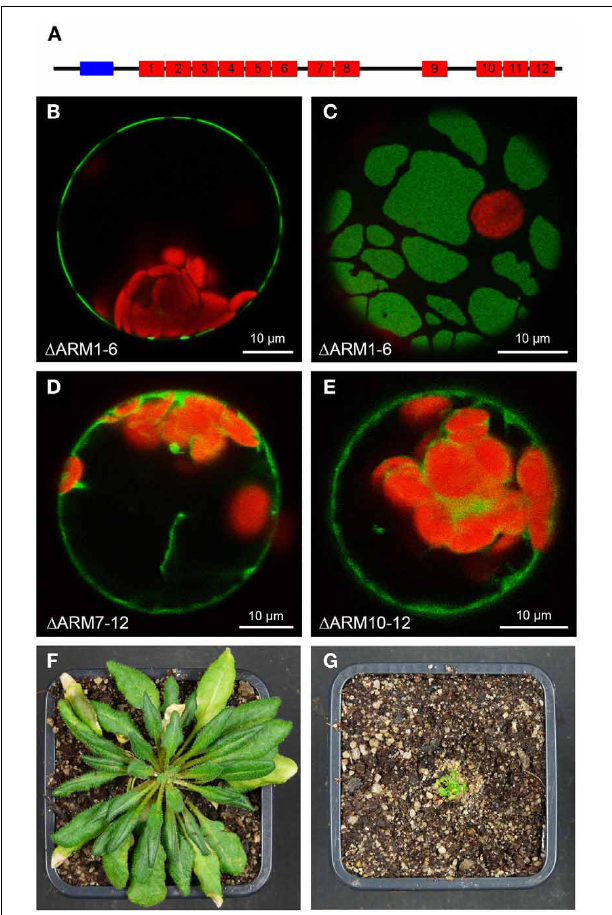
FIGURE 1 | Involvement of C-terminal ARM repeats in plasma membrane-association of AtPUB43. (A) Schematic representation of the AtPUB43 protein domain structure. U-box and ARM repeats are depicted in blue and red, respectively. (B) Confocal analysis of fluorescence of an Arabidopsis leaf protoplast expressing AtPUB43 (cid:2) ARM 1 − 6 -GFP fusion proteins. GFP fluorescence depicted in green was only detected at the plasma membrane. Chlorophyll auto-fluorescence within the chloroplasts is depicted in red. (C) Confocal analysis of fluorescence of an Arabidopsis leaf protoplast expressing AtPUB43 (cid:2) ARM 1 − 6 -GFP fusion proteins. The representative top-view showed that GFP signals and thus the AtPUB43 (cid:2) ARM 1 − 6 -GFP fusion proteins were localized in membrane patches. (D) Confocal analysis of fluorescence of an Arabidopsis leaf protoplast expressing AtPUB43 (cid:2) ARM 7 − 12 -GFP fusion proteins. GFP fluorescence depicted in green was detected in the cytosol. Chlorophyll auto-fluorescence within the chloroplasts is depicted in red. (E) Confocal analysis of fluorescence of an Arabidopsis leaf protoplast expressing AtPUB43 (cid:2) ARM 10 − 12 -GFP fusion proteins. GFP fluorescence depicted in green was detected in the cytosol. Chlorophyll auto-fluorescence within the chloroplasts is depicted in red. (F) Growth phenotype of wildtype plants grown for 12 weeks in short-day conditions. Photon flux density was